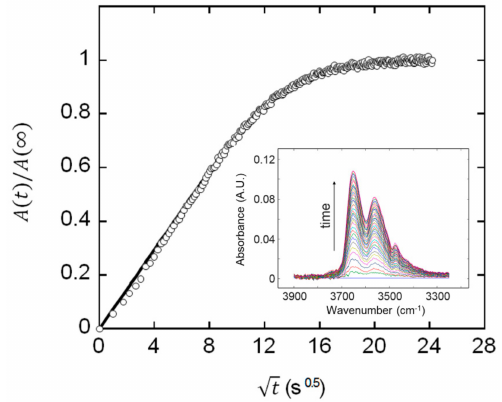
√ Figure 3. Fick’s plot ( A ( t )/ A ( ∞ ) vs t) for the sorption test at p / p 0 = 0.6 at T = 303.15 K. The inset displays the time-evolution of the analytical